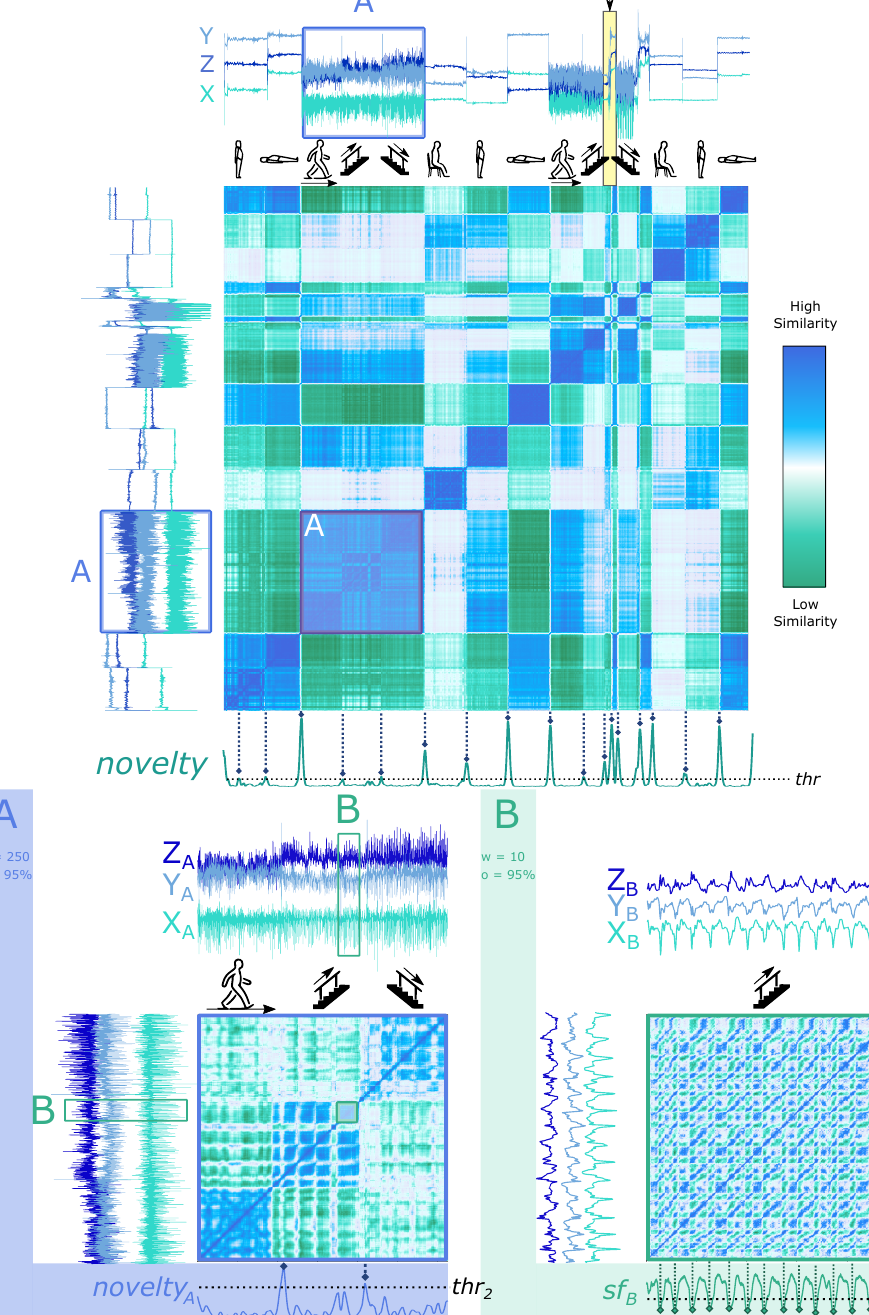
Figure 6. An SSM-based novelty search strategy to detect segmentation events on a signal piece from Dataset 1 (HAR, see Section 3.1). ( Top ): window size = 250 samples, kernel size = 45 samples, and overlap = 95% on the activity sequence Standing −→ Laying −→ Walking −→ Upstairs −→ Downstairs −→ Sitting −→ Standing −→ Laying −→ Walking −→ Upstairs −→ Downstairs −→ Sitting −→ Standing −→ Laying . The novelty function is presented and peaks are aligned with ground truth events, represented as the dashed line and circles; ( bottom left ): signal change point detection